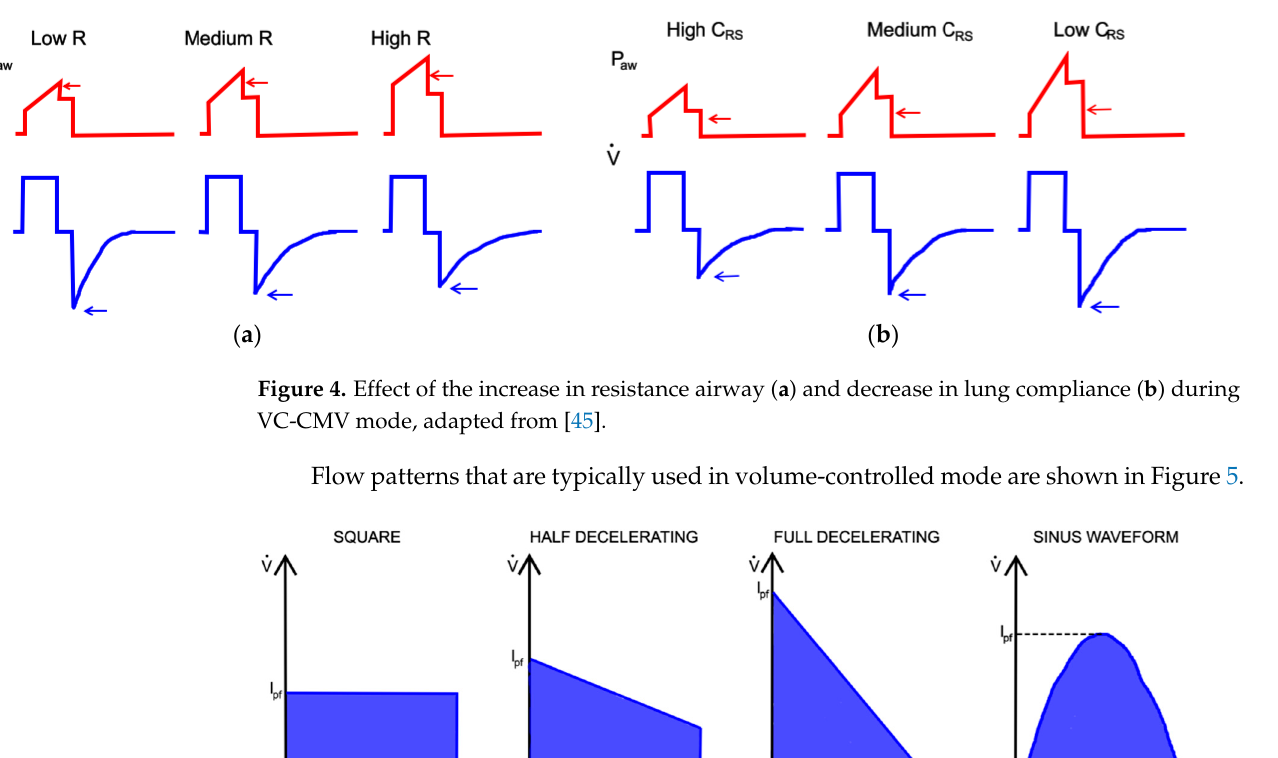
Figure 3. A display of pressure, volume, and flow waveforms during VC − CMV mode: ( a ) ma ‐